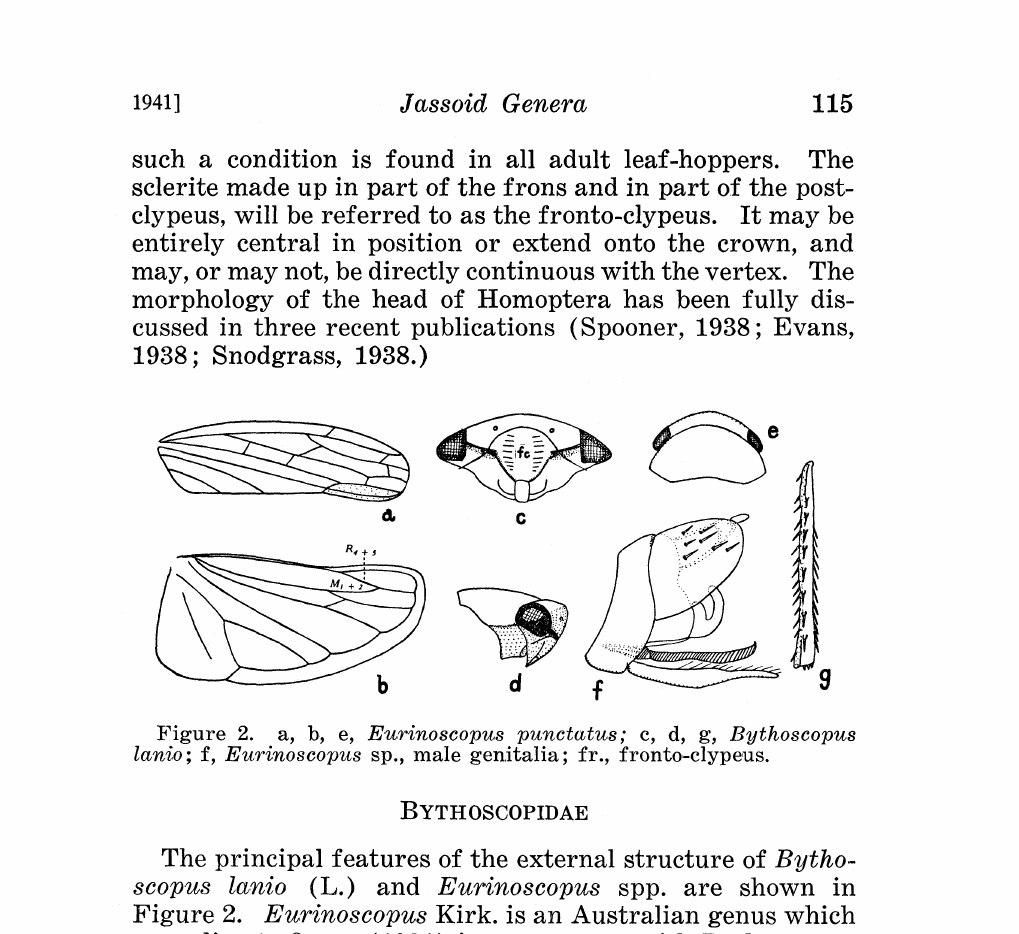
Figure 2. a, b, e, Eurinoscopu.s pu.nctatus; c, d, g, Bythoscopus lanio; f, Eurinoscopus sp., male genitalia; fr., fronto-clypeus.